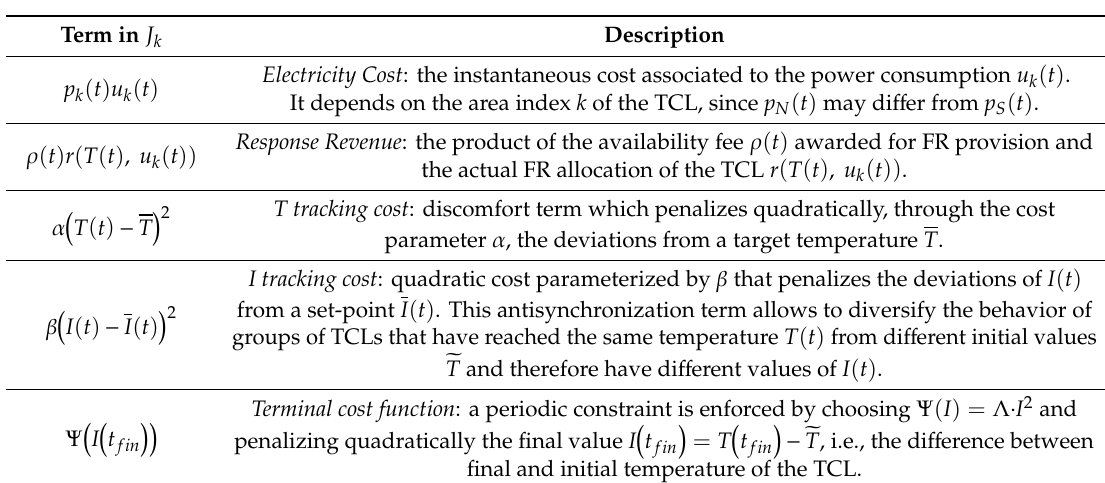
Table 1. Description of the terms of the TCL cost function J k